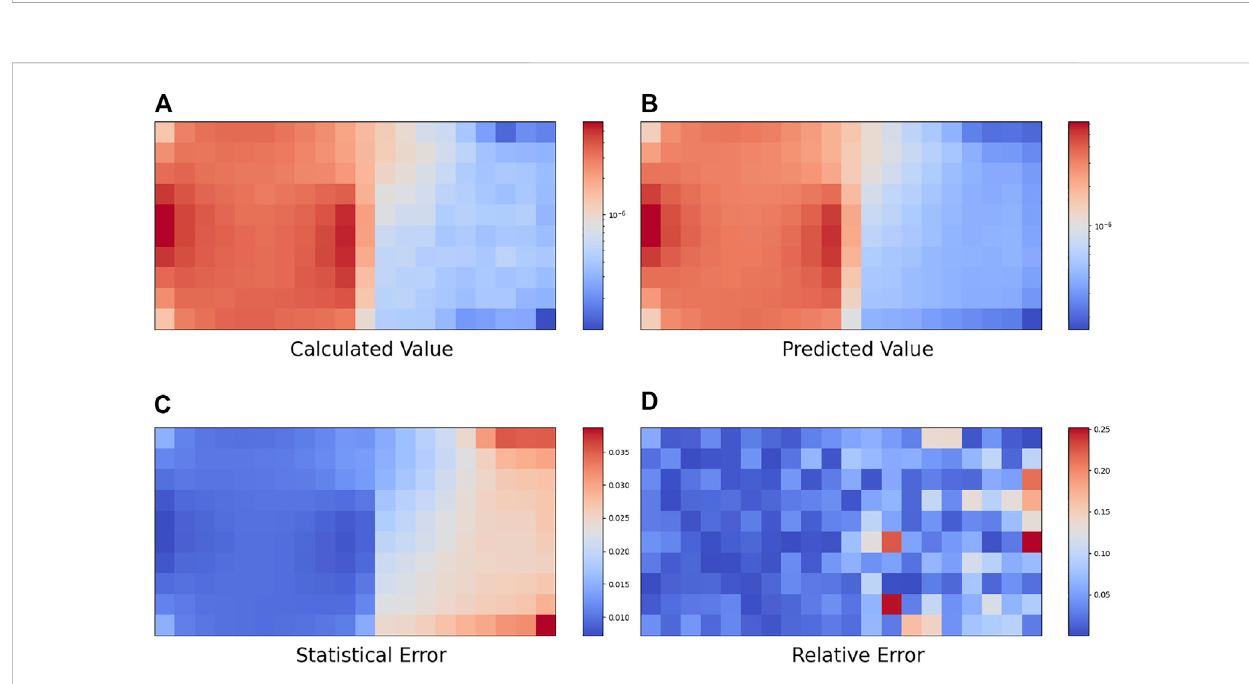
FIGURE 8 Reconstruction results of the single energy source